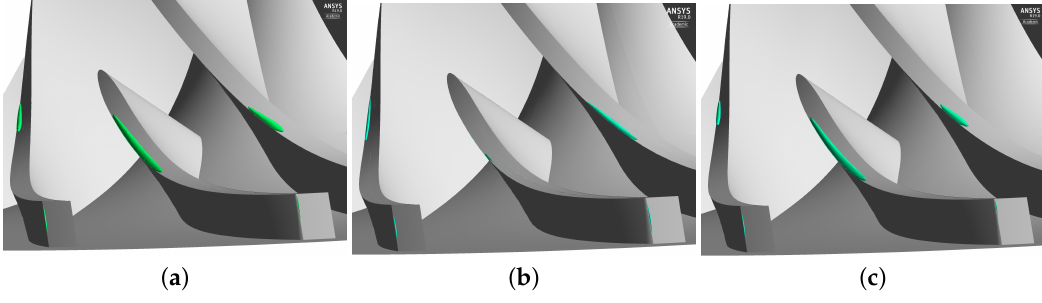
Figure 15. Volume shows the regions near trailing edge where the pressure is lower than the inlet pressure at a mass flow rate of 3.2 kg/s. ( a ) Impeller alone. ( b ) With vaneless diffuser. ( c ) With vaned diffuser.